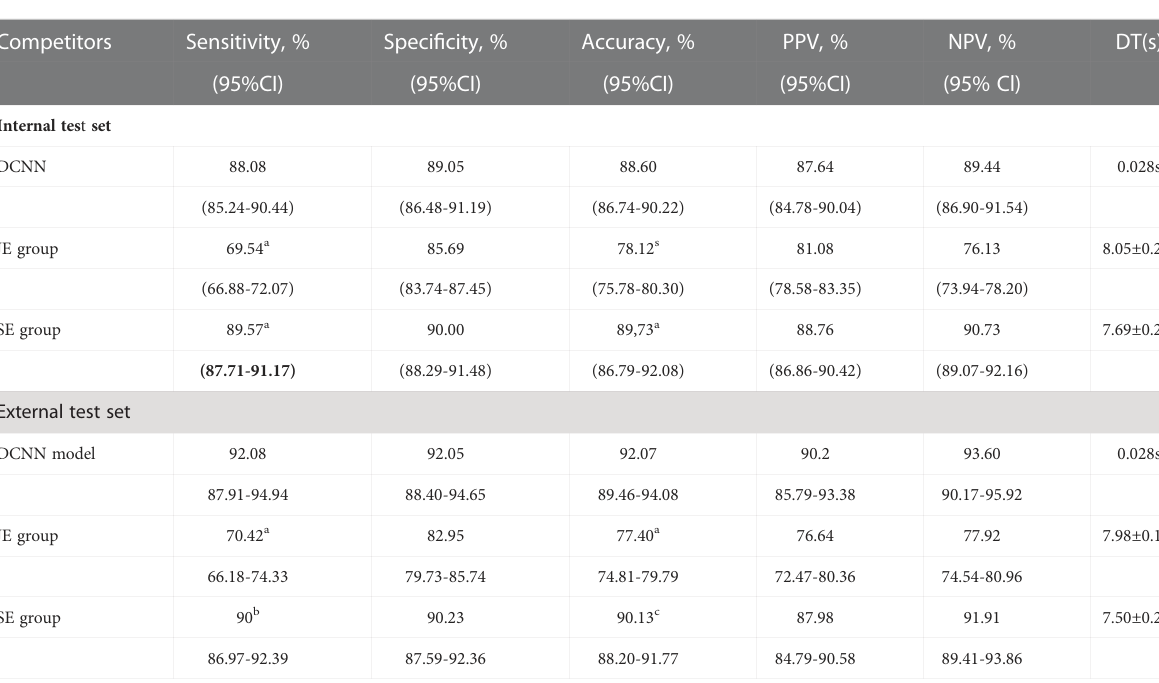
TABLE 2 The performances of DCNN and endoscopist in internal test set and external test